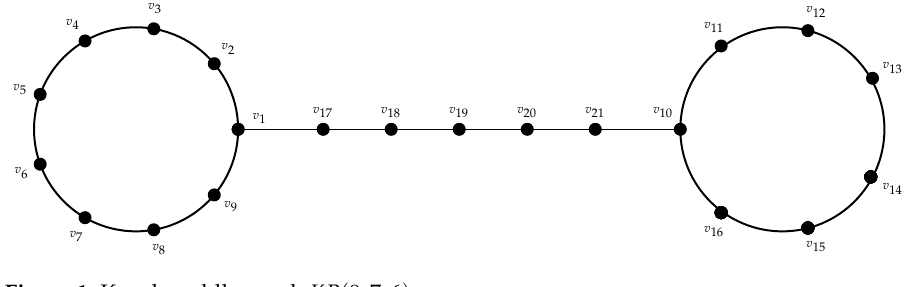
Figure 1. Kayak paddle graph KP ( 9,7,6 )